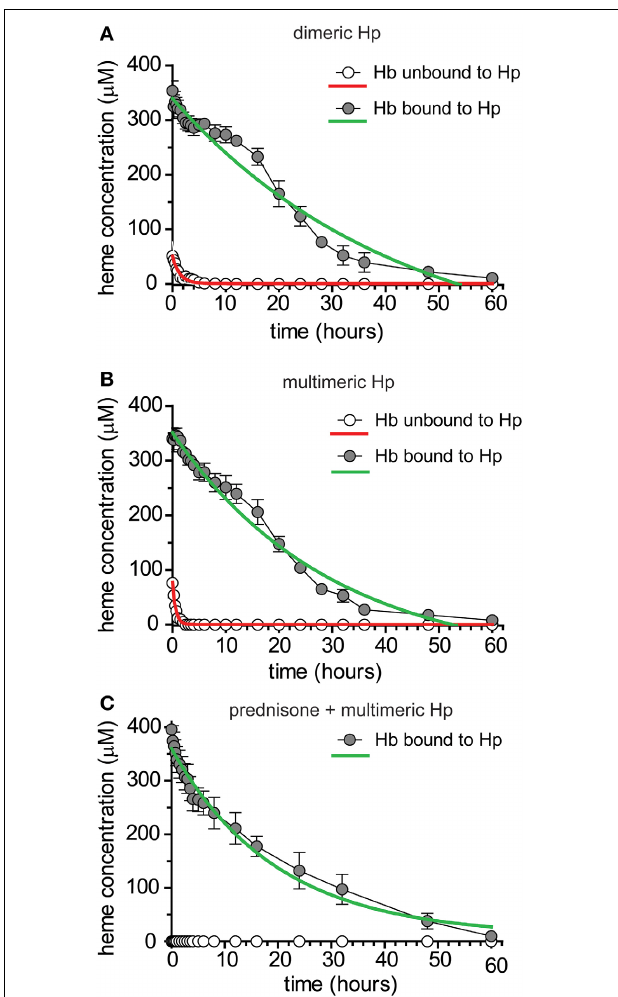
FIGURE 4 | Pharmacokinetics of human Hb following administration of dimeric or multimeric Hp ± glucocorticoid up-regulation of Hb clearance systems. (A) Mean ± SEM plasma concentration vs. time plotted for human purified Hb + human purified dimeric Hp administered to beagle dogs ( n = 6). Data are fitted to a single exponential decay (red and green traces) and represent total heme bound to Hb + Hb:Hp. Pharmacokinetic parameter estimates are shown in Table 3 . (B) Mean ± SEM plasma concentration vs. time plotted for human purified Hb + human purified multimeric Hp administered to beagle dogs ( n = 6). Data are fitted to a single exponential decay (red and green traces) and represent total heme bound to Hb + Hb:Hp. Pharmacokinetic parameter estimates are shown in Table 3 . (C) Mean ± SEM plasma concentration vs. time plotted for prednisone pre-treated Beagle dogs administered human purified Hb + human purified multimeric Hp ( n = 6). Gray circles represent Hb:Hp complex and open circles represent unbound Hb. No unbound Hb was detected, as result data is set to zero. Data are fitted to a single exponential decay (red and green traces) and represent total heme bound to Hb + Hb:Hp. Pharmacokinetic parameter estimates are shown in Table 4